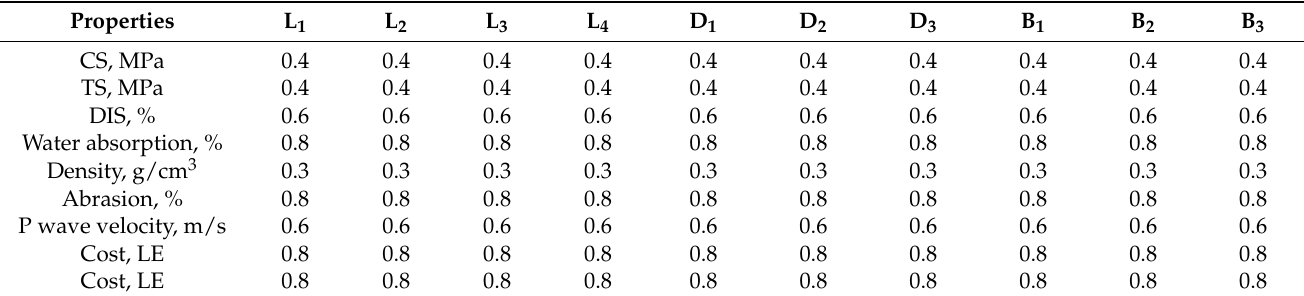
Table 3. Assignment of weights of to the tested rock samples.